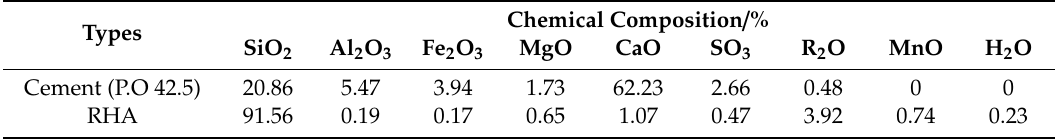
Table 2. Chemical composition of the cementitious materials.